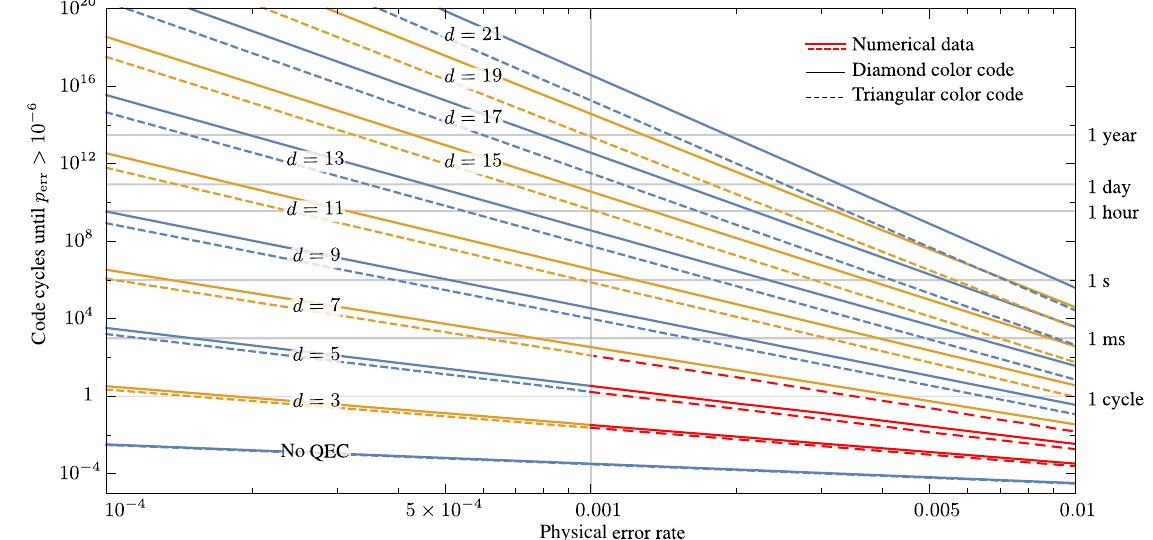
FIG. 23. Survival time of triangular (dashed lines) and diamond (solid lines) color-code qubits until the logical error probability p reaches 10 − 6 for increasing code distances obtained from extrapolation of the numerical data (red). The labels on the right-hand side of the time axis show the survival time for a code cycle duration of 1 μ s .